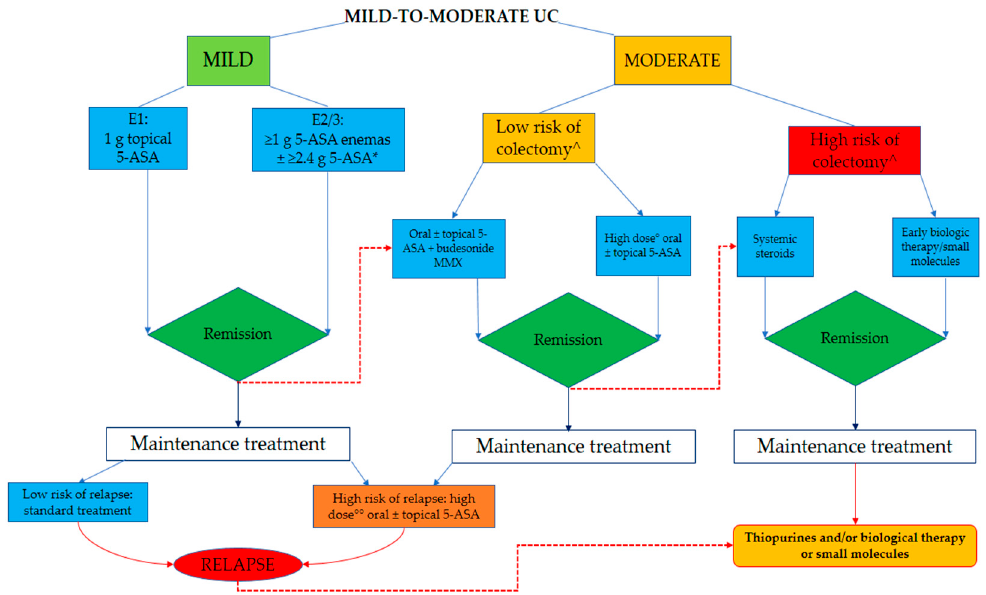
Figure 2. Proposed algorithm for the management of mild-to-moderate UC. *: OD dosing and MMX mesalamine are valuable options. ˆ: according to prognostic factors: young age at diagnosis, extensive disease, extra-intestinal manifestations, presence of endoscopic signs of disease activity (e.g., ulcers), and elevated inflammatory biomarkers. °: ≥ 4 g/day; °°: >2 g/day.